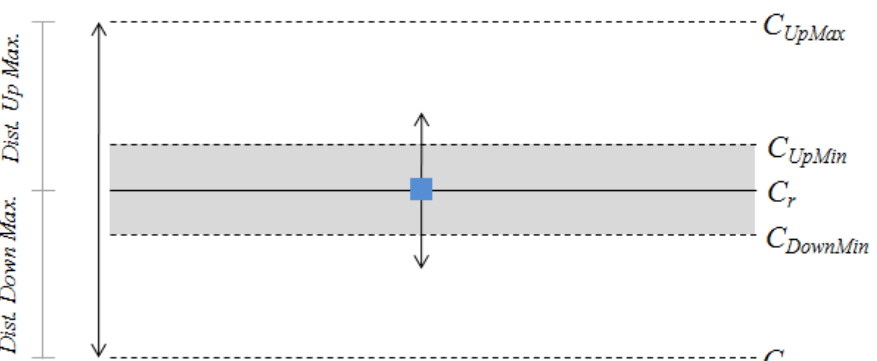
Figure 11. Parameters of the input space used by the